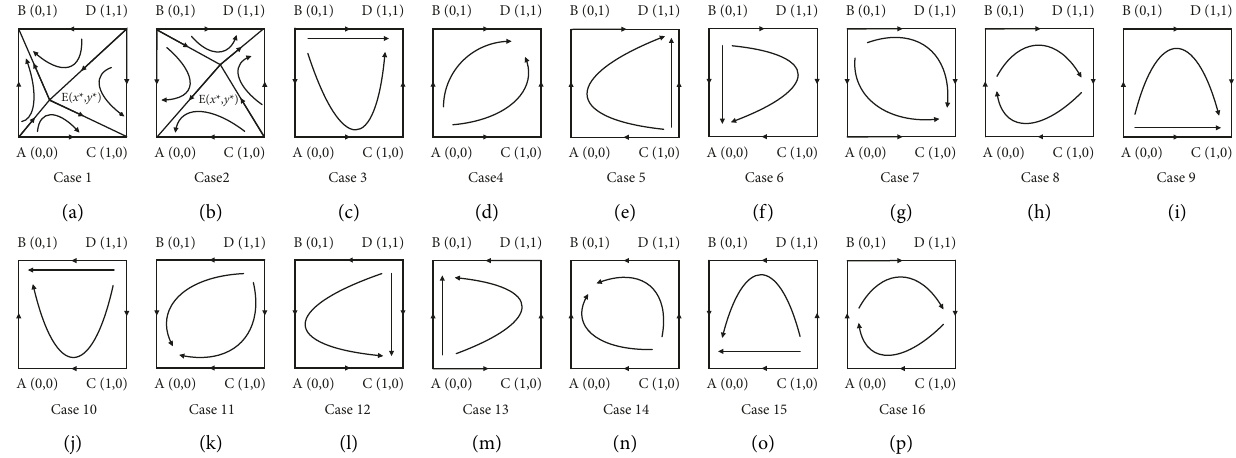
Figure 1: System evolution path in each case. (a) Case 1; (b) Case 2; (c) Case 3; (d) Case 4; (e) Case 5; (f) Case 6; (g) Case 7; (h) Case 8; (i) Case 9; (j) Case 10; (k) Case 11; (l) Case 12; (m) Case 13; (n) Case 14; (o) Case 15; (p) Case